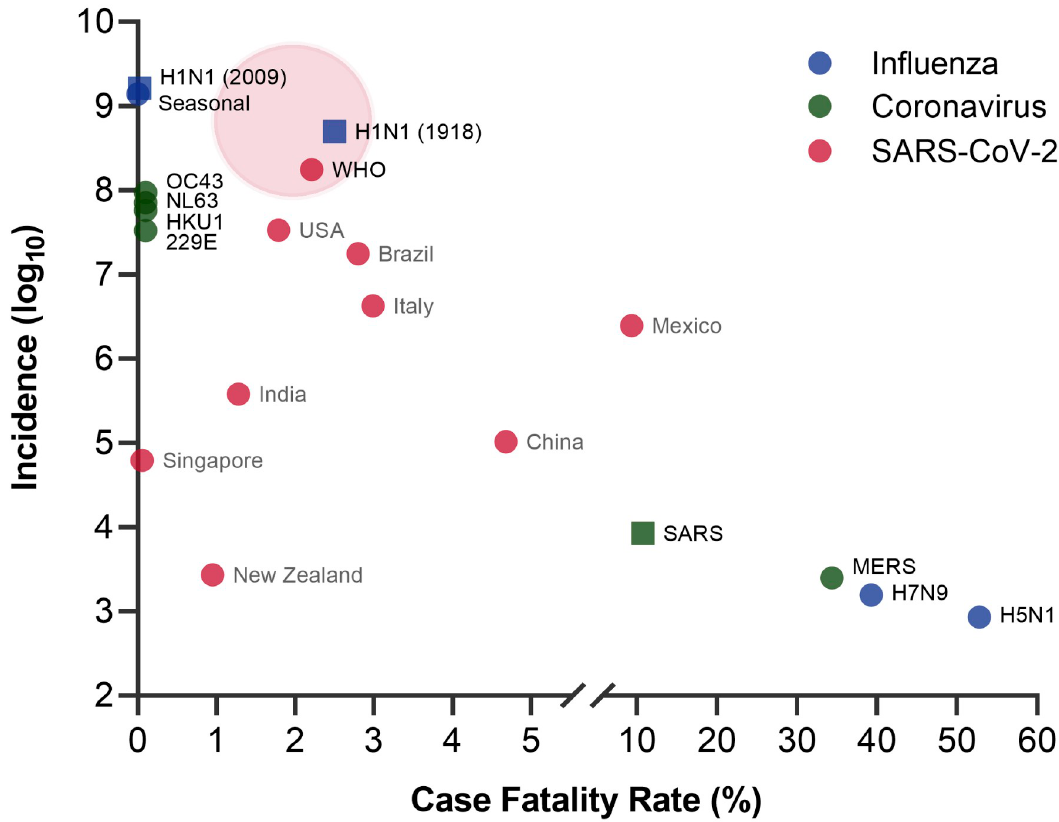
Fig 1. Transmission and pathogenesis of CoVs and influenza viruses. An inverse relationship exists between transmission (incidence) and pathogenesis (CFR) as the more transmissible viruses are less pathogenic (e.g., hCoVs and seasonal influenza) and vice versa (e.g., MERS and H5N1 influenza). SARS-CoV-2 has established a balance displaying high transmissibility and moderate pathogenesis, similar to the 1918 H1N1 influenza. The CFR of SARS-CoV-2 vary among individual countries, with WHO representing the global values. The red cloud represents an estimated range of the final SARS-CoV-2 incidence and CFR. ● represents ongoing or seasonal values; & represents historical values. CFR, case fatality rate; CoV, coronavirus; hCoV, human coronavirus; MERS, Middle East Respiratory Syndrome; SARS, Severe Acute Respiratory Syndrome; SARS-CoV-2, Severe Acute Respiratory Syndrome Coronavirus 2; WHO, World Health